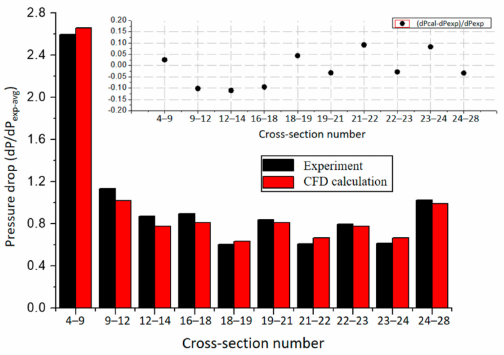
Figure 12. Pressure drop monitoring planes.